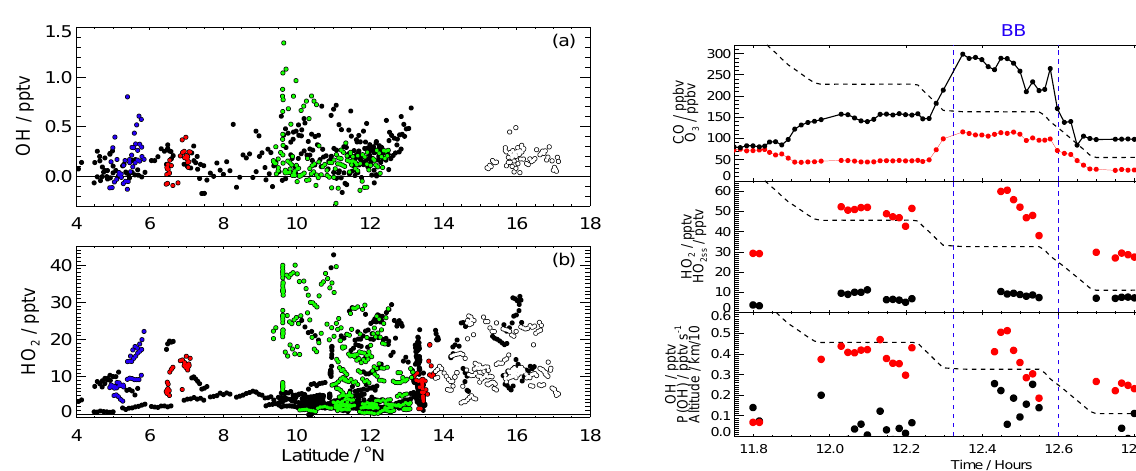
Fig. 20. Time series within and around a biomass burning (BB) plume with (a) CO (ppbv, black), and O 3 (ppbv, red), (b) HO 2 (pptv, black) and HO 2 ss (pptv, red), (c) OH (pptv, black) and P (OH) (pptvs − 1 , red). On all graphs altitude is indicated by a black dashed line. All data are averaged to